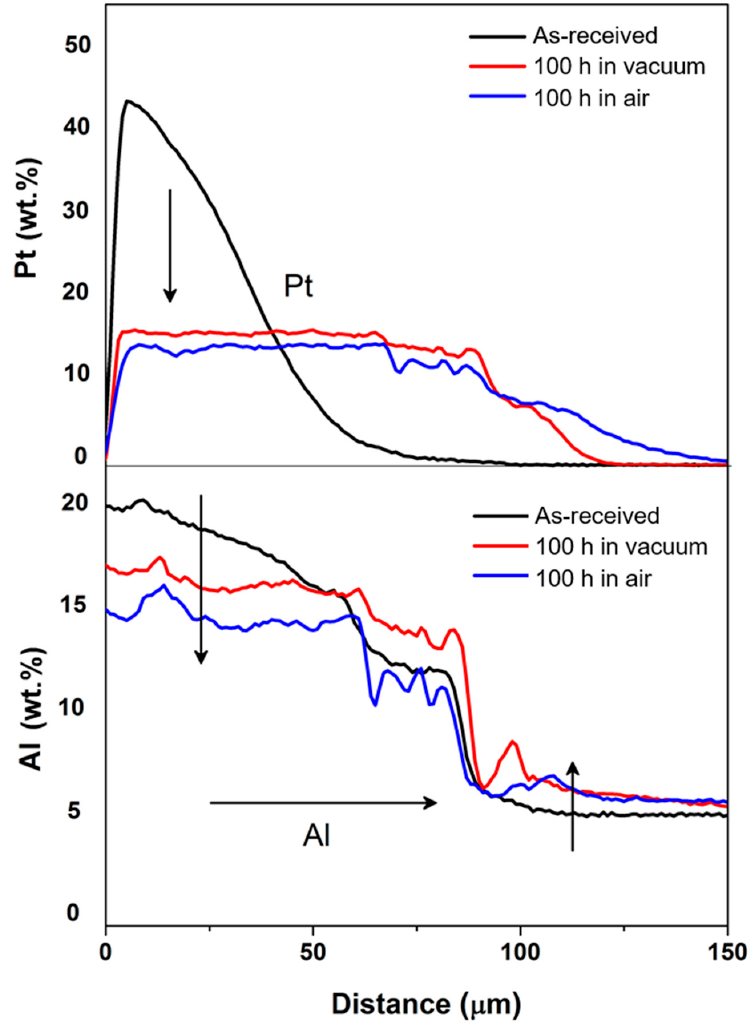
Figure 9. Pt and Al concentrations on the cross-sections of Pt-aluminide β bond coats. Table 2. Main phase and elements in the Pt-aluminide β bond coat.